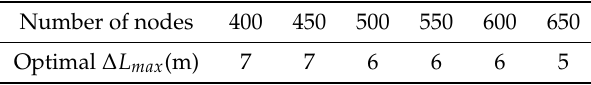
Table 6. Optimal ∆ L max for different numbers of